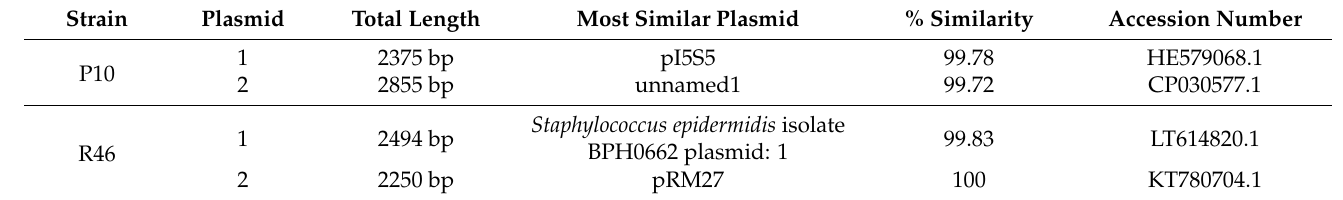
Table 3. Summary of plasmids present in MRSA ST113 strains P10 and R46.